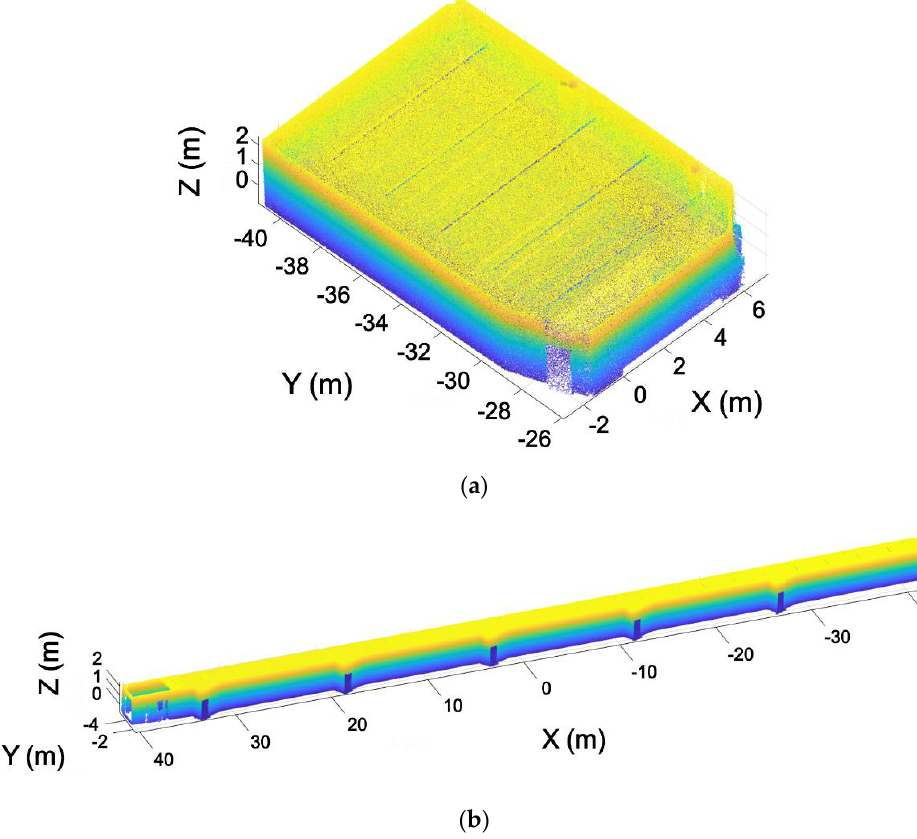
Figure 20. Segmentation results. ( a ) Standard room. ( b ) Corridor.